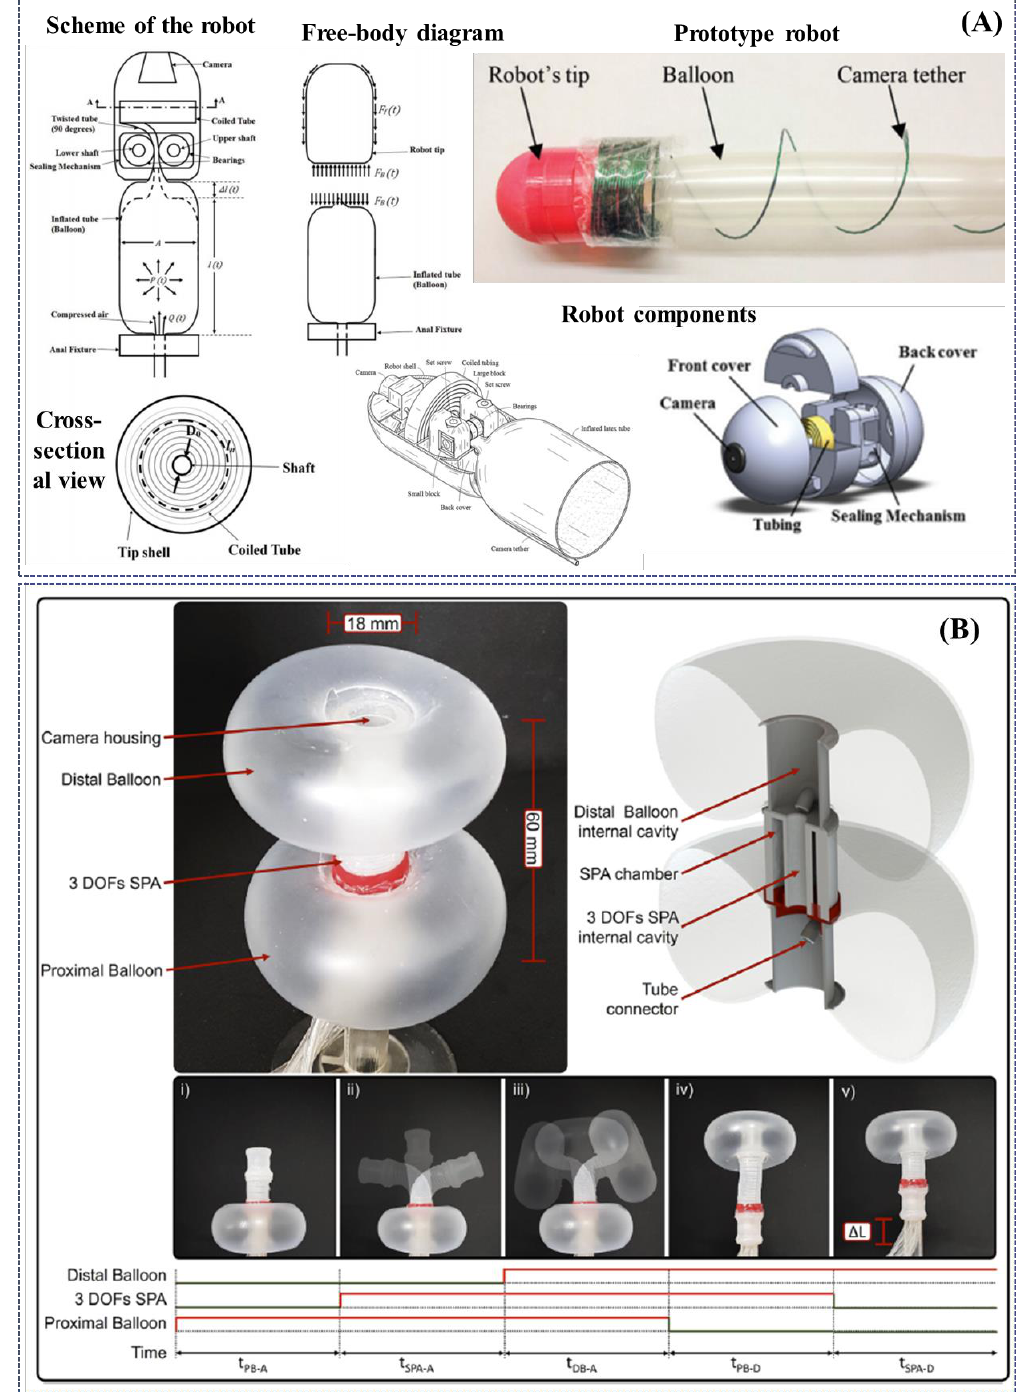
Figure 5. Examples of research-oriented innovative robotic colonoscopes and devices with pneumatic actuation: ( A ) self-steering pneumatically driven colonoscopy robot developed by Dehghani et al. [101]; ( B ) soft pneumatic inchworm double balloon (SPID) colonoscope developed by Manfredi et al.